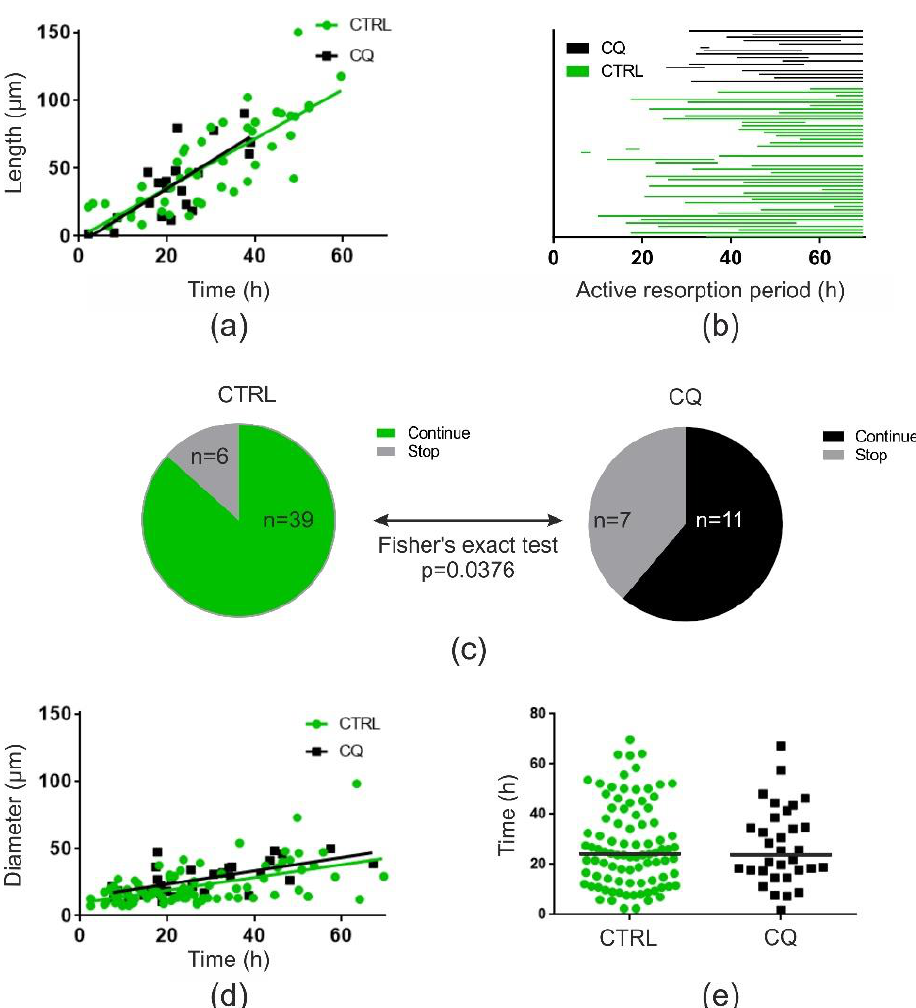
Figure 4. Quantification of time-lapse recording: Chloroquine (10 µM) reduces the duration of resorption but not the speed of OCs making trenches; OCs making pits are unaffected, illustrated by data obtained from time-lapse recordings with OCs from a single donor. ( a ) Relation between length of trench and time of active resorption for all trenches identified in one experiment, subdivided into control (CTRL; green; n = 47) with a linear regression fit of r 2 = 0.65 and p < 0.0001 and chloroquine-treated (CQ; black; n = 20) with a linear regression fit of r 2 = 0.57 and p = 0.0001. Slopes and y-intercepts of both linear regression fits were tested and found not to be different ( p = 0.6738 and p = 0.9678, respectively) ( b ) Diagram visualizing the timeframes of active resorption for individual OCs making trenches, subdivided into control (green; n = 45) and chloroquine-treated (black; n = 18). ( c ) Pie chart showing the percentage of trench-making OCs that stop resorption during time-lapse recording (grey) compared to those that continue throughout recording in control (green) and chloroquine (grey) conditions. Statistics: Fishers exact test ( p = 0.0376). ( d ) Relation between diameter of pits and time of active resorption for all pits identified in one experiment, subdivided into control (green; n = 86) with a linear regression fit of r 2 = 0.28 and p < 0.0001 and chloroquine-treated (black: n = 31) with a linear regression fit of r 2 = 0.40 and p < 0.0001. Slopes and y-intercepts of both linear regression fits were tested and found not to be different ( p = 0.9075 and p = 0.0622, respectively). ( e ) Active resorption time for all pits identified in one experiment for control (green; n = 91) and chloroquine (black; n = 32). Statistics: Mann–Whitney test ( p = 0.9999).